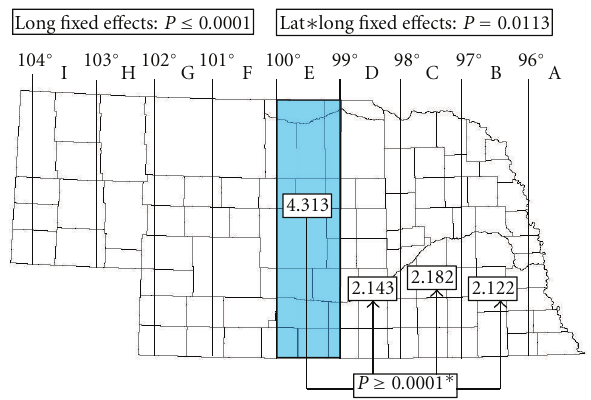
Figure 8: Mean elytral color by code for Cicindela splendida by lon- gitudinal region. Significant di ff erences between longitudes shown by arrows and mean value presented in each longitudinal grouping. Fixed e ff ects presented at top. No latitude by longitude interactions found. Shaded area depicts longitudinal regions di ff ering from others.